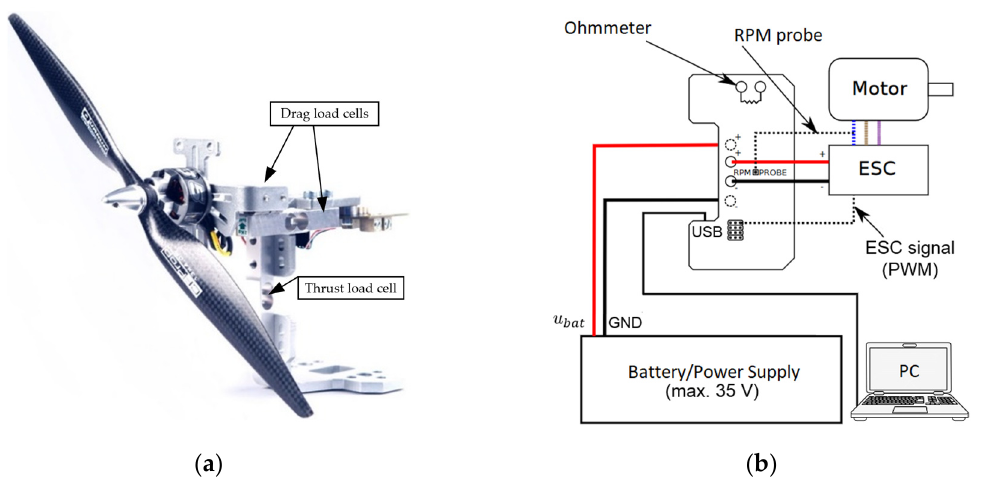
Figure 4. RCbenchmark measurement system: ( a ) hardware; ( b ) wired measurement setup.